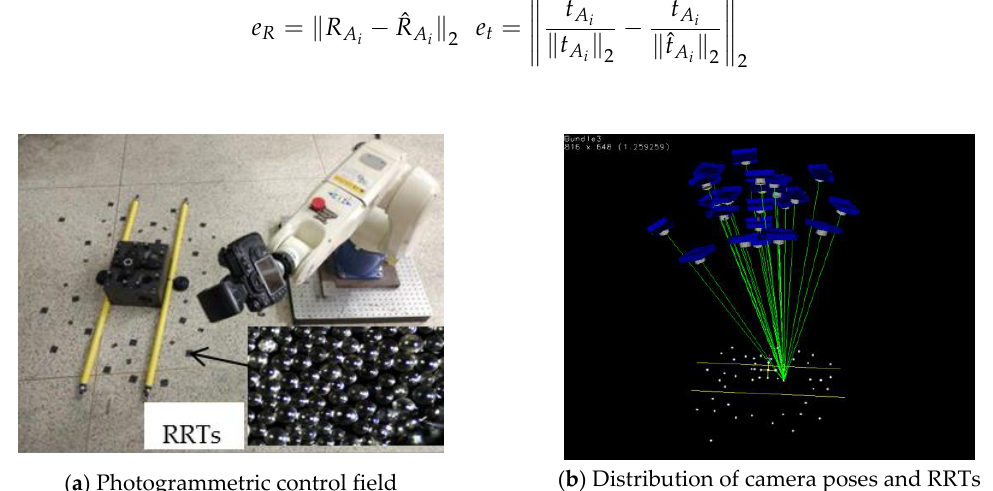
Figure 6. Photogrammetric scene data set experiment: ( a ) Photogrammetric control field; ( b ) Distribution of camera pose and target points.